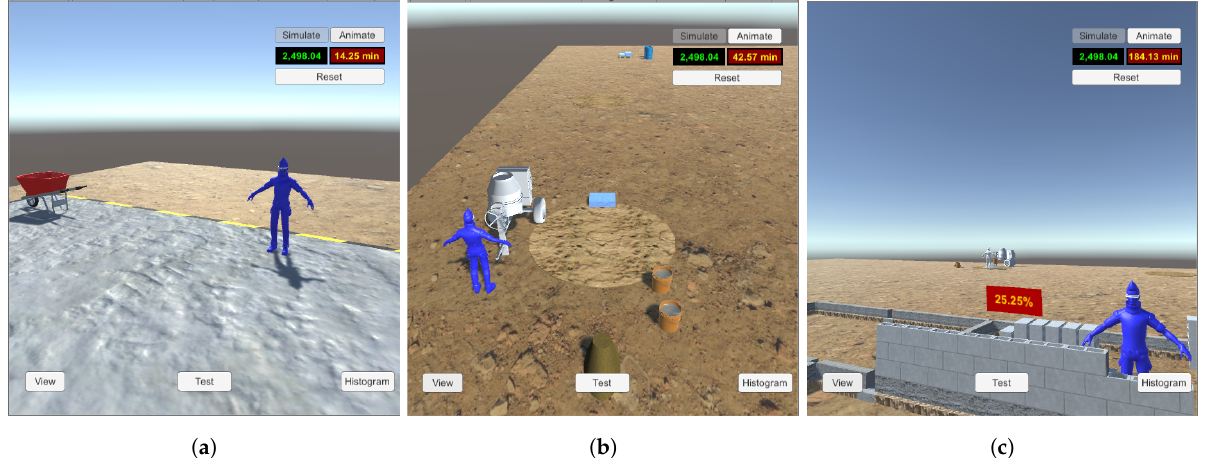
Figure 14. Resources at different points in time in Scenario 2. ( a ) Mason idle at time 14.25. ( b ) Mason preparing mortar at time 42.57. ( c ) Mason laying block at time